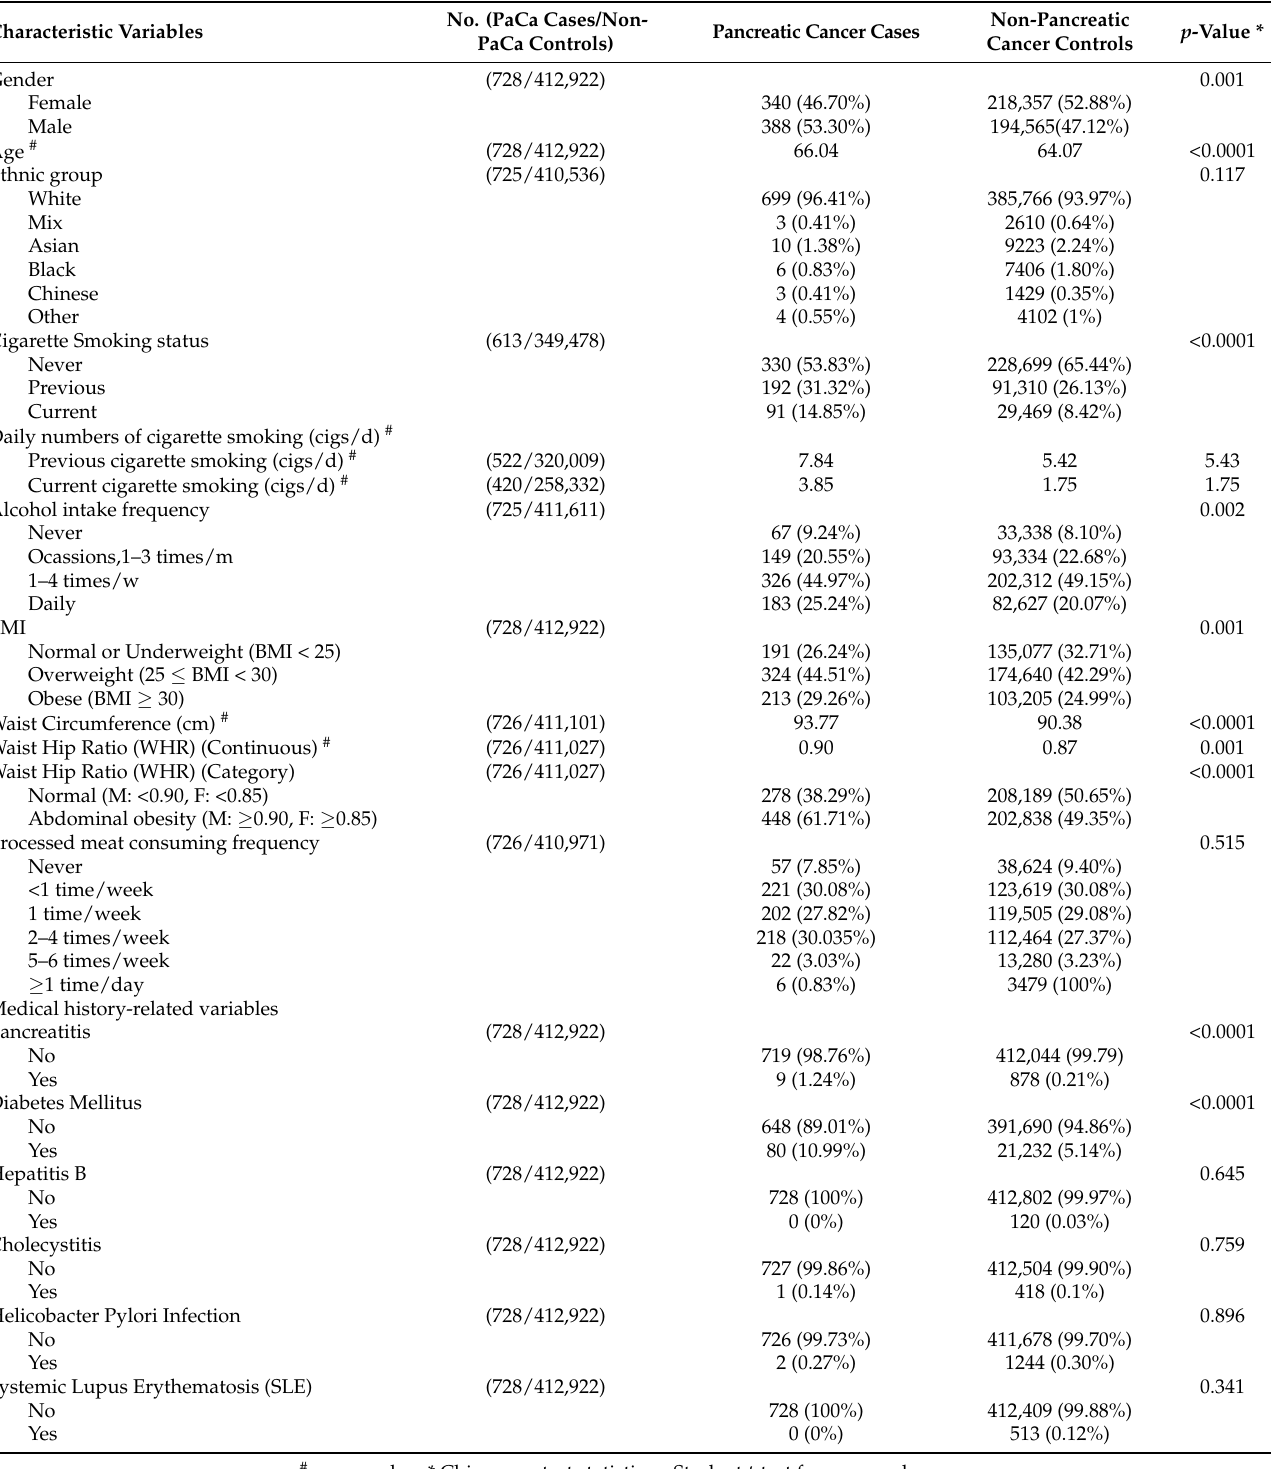
Table 1. Demographic characteristics of pancreatic cancer (PaCa) case group and non-pancreatic cancer (Non-PaCa) control